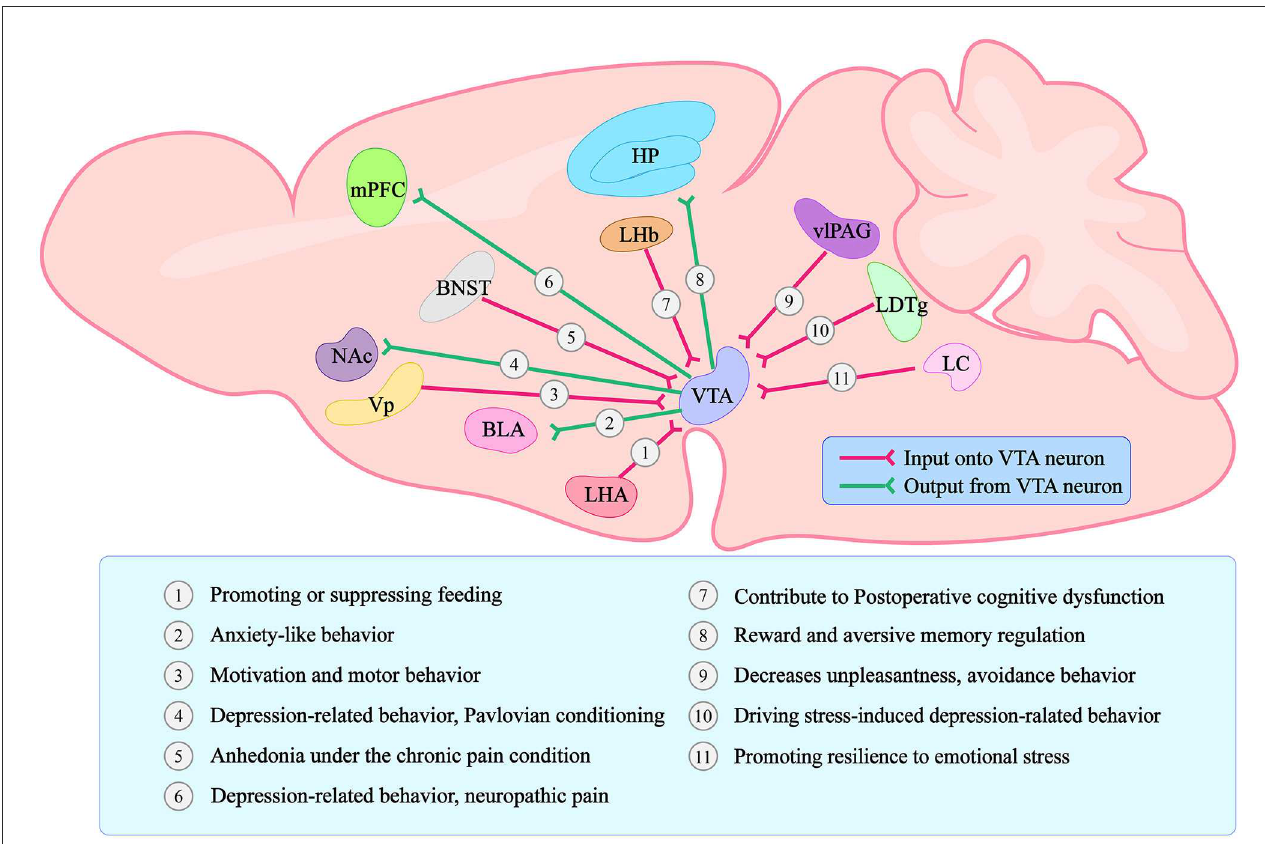
FIGURE1 Graphical summary of the VTA connections with other brain regions and the main functions regarding each different projection. Forms and positions can only represent the general structure and position. The lines with arrows only represent a simplified schematic of the general projection pattern. VTA stands for Ventral Tegmental Area; LHA stands for lateral hypothalamic area; BLA stands for basolateral amygdala; Vp stands for ventral pallidum; NAc stands for Nucleus Accumbens; BNST stands for bed nucleus of the stria terminalis; mPFC stands for medial prefrontal Cortex; LHb stands for lateral habenula; HP stands for Hippocampus; vlPAG stands for ventrolateral periaqueductal gray; LDTg stands for laterodorsal tegmentum; LC stands for locus